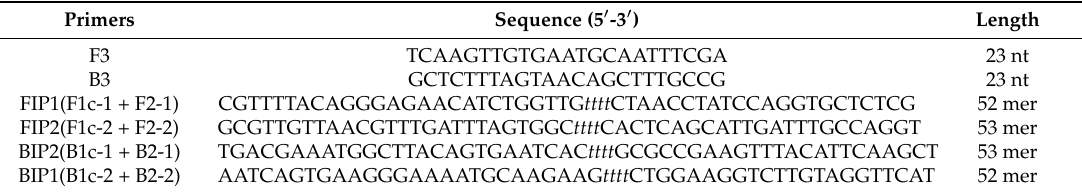
Table 1. Primers used for MIP-LAMP amplification.